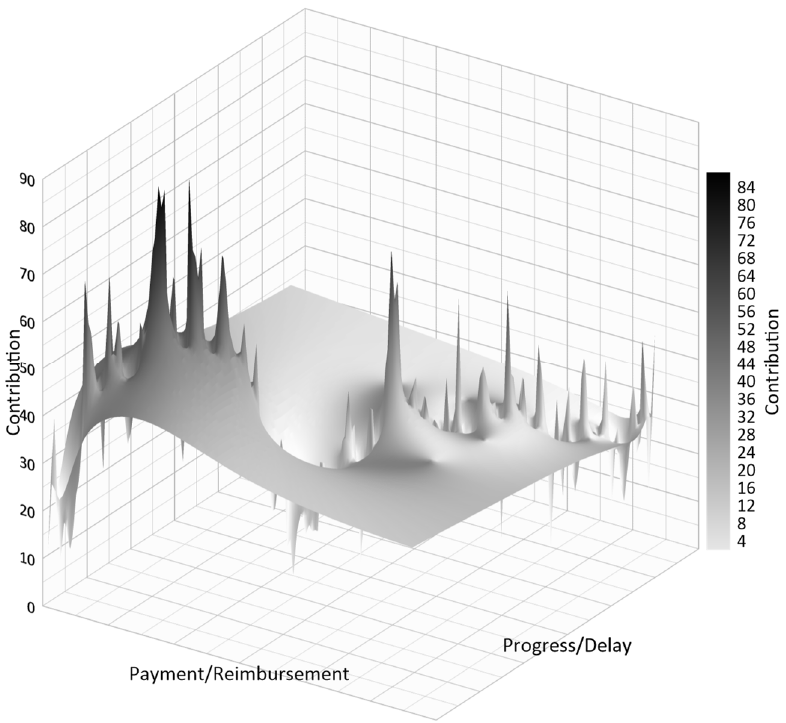
Figure 10. Interaction between ‘Payment/Reimbursement’ and ‘Progress/Delay’ disputes using MARS technique.